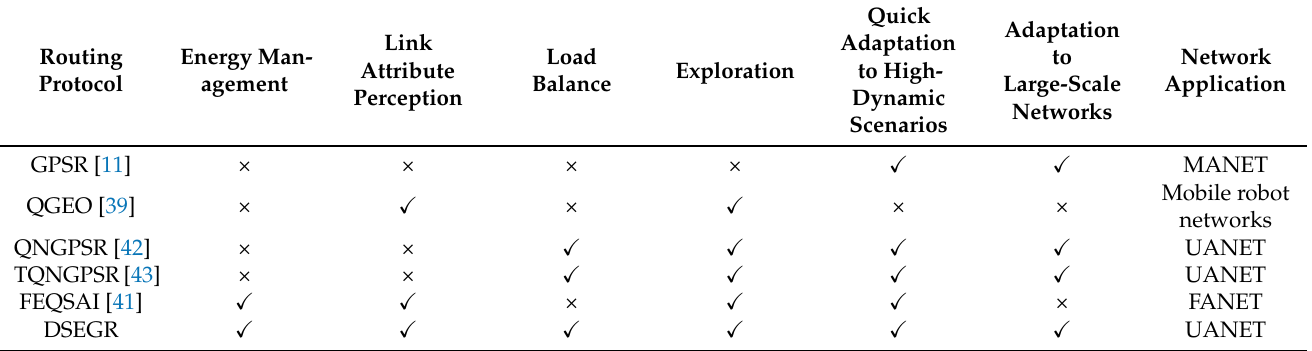
Table 1. Characteristics of different routing